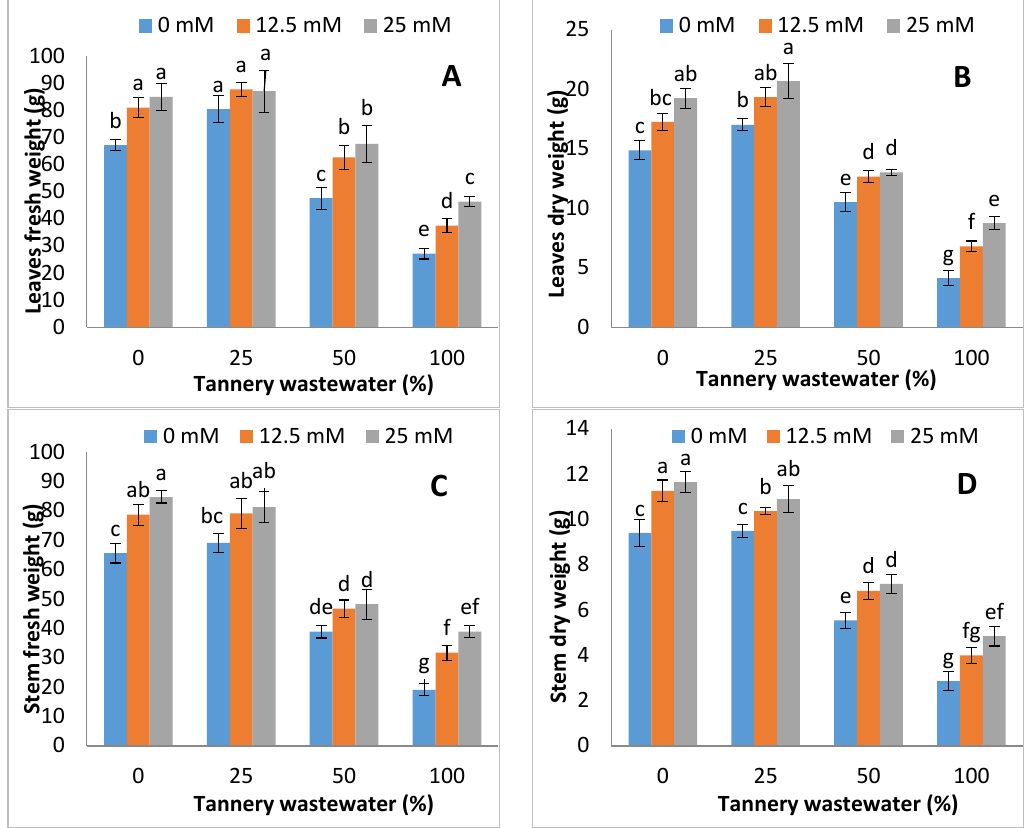
and dry biomass, either with or without tannery wastewater treatments. The highest fresh and dry biomass was recorded in Zn-lys application at 25 mM dose under control, and each tannery wastewater treatment (Figure 2).